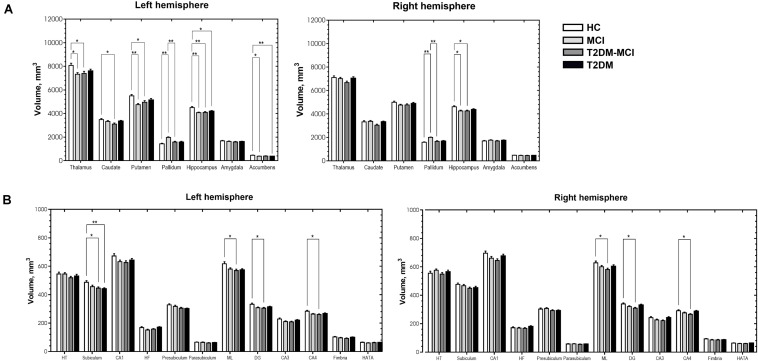
Significant differences in subcortical volume (A) and volume of the hippocampal subfields (B) among the HCs, patients with MCI, patients with type 2 diabetes mellitus and mild cognitive impairment (T2DM-MCI) and patients with type 2 diabetes mellitus (T2DM). *Bonferroni-corrected p-value < 0.05. **Bonferroni-corrected p-value < 0.001. The error bars indicate standard errors. HT, hippocampal tail; CA, cornu ammonis; HF, hippocampal fissure; ML, molecular layer; DG, granule cell layer of dentate gyrus; HATA, hippocampus-amygdala-transition-area.